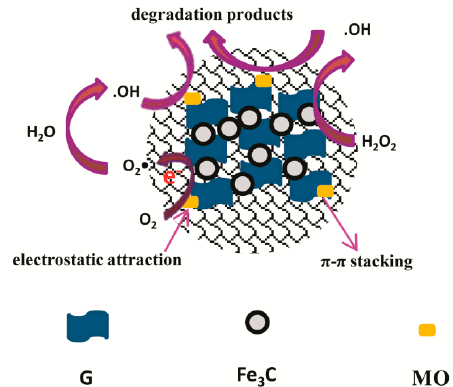
Figure 9. EPR spectra of: ( a ) DMPO-OH adducts and ( b ) DMPO-O 2 − adducts.